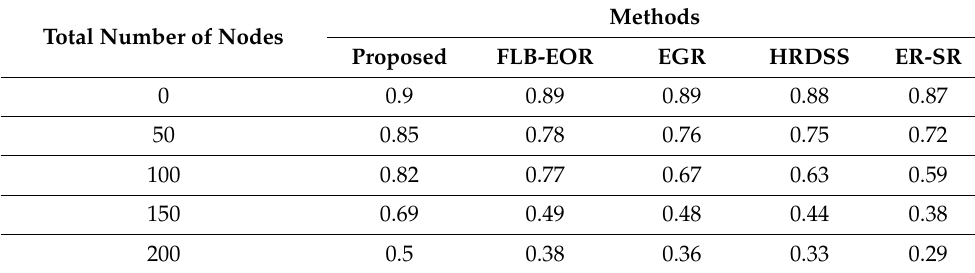
Table 8. Comparative results based on packet delivery ratio.